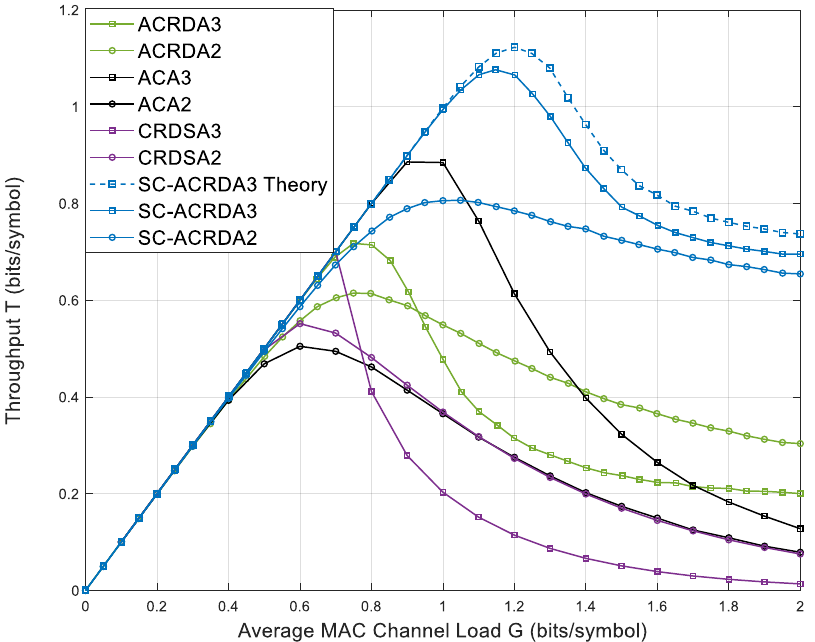
Figure 7. Comparison of throughput of SC-ACRDA2 and SC-ACRDA3 with other schemes.